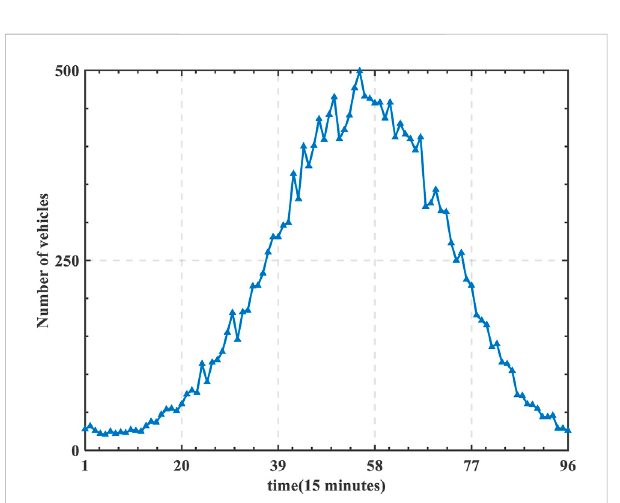
FIGURE 6 Distribution of departure vehicles.